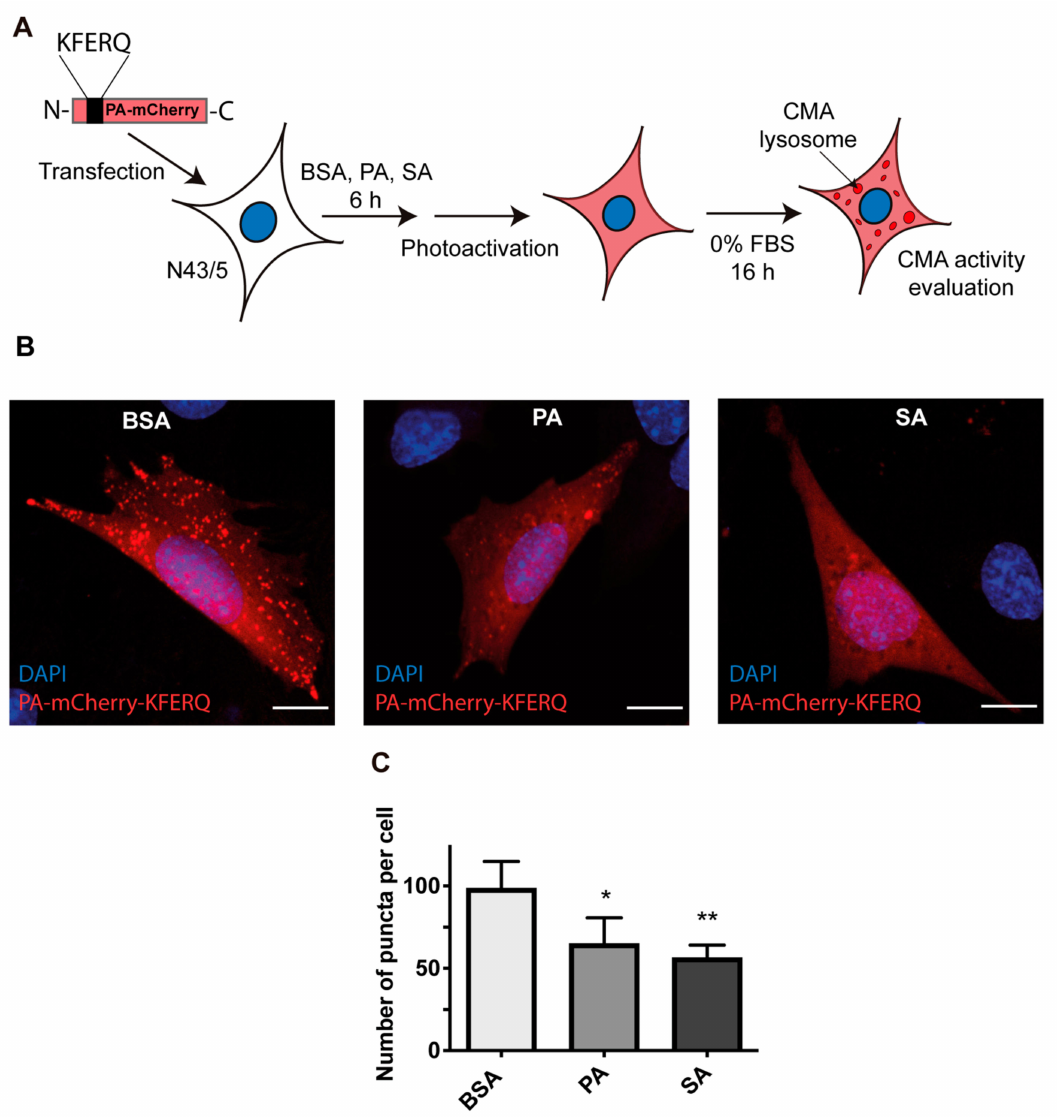
Figure 4. CMA activity, measured by a specific CMA fluorescent reporter, is inhibited in POMC-like neurons treated with PA and SA. ( A ) Cells were transfected with PA-mCherry-KFERQ plasmid DNA, treated with BSA or 100 µ M of PA or SA for 6 h, and then photoactivated and starved for 16 h. ( B ) Representative fluorescent images showing the PA-mCherry-KFERQ puncta (red) in BSA, PA, or SA conditions (blue corresponds to cell nuclei). Scale bar = 20 µ m. ( C ) Puncta per cells were quantified by ImageJ 1.8.0 (National Institutes of Health, NIH, MD, USA) and analyzed using the unpaired t test ( n = 4) * = p < 0.05, ** = p <